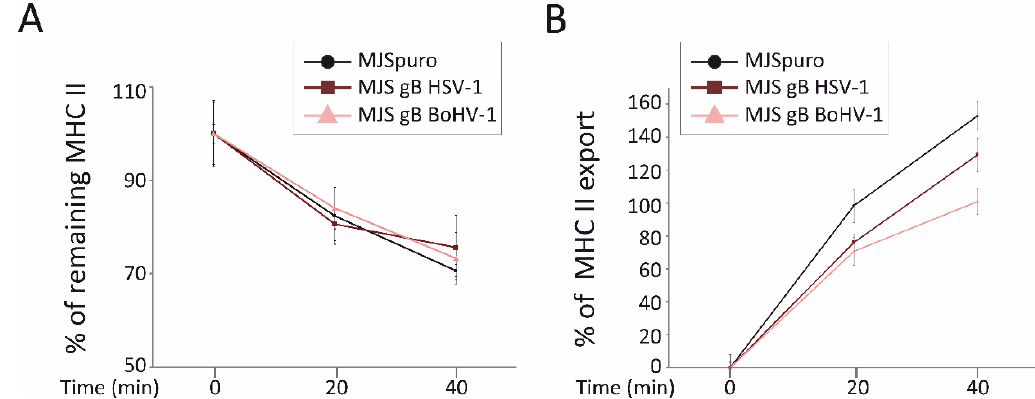
Figure 6. HSV-1 and BoHV-1 gB do not a ff ect internalization but contribute to a retarded appearance of MHC II at the cell surface. ( A ) An internalization assay was performed on MJS HSV-1 gB (dark brown line), MJS BoHV-1 gB (pink line), or control MJSpuro (black line) cells stained on ice with anti-MHC class II L243 antibody and PE-conjugated IgG. The cells were then shifted to 37 ◦ C for 20 or 40 min. The mean fluorescence intensities of remaining MHC II were assessed by flow cytometry for triplicate samples and compared with MHC II at time point 0 (set as 100%). The di ff erences between MHC II levels were statistically insignificant. ( B ) For the MHC II export assay, the cells were stained on ice with a saturating amount of anti-MHC class II L243 antibody and incubated at 37 ◦ C for 20 or 40 min in the presence of allophycocyanin (APC)-conjugated L243 MAb detecting newly arrived MHC II. The mean fluorescence intensities of MHC II staining were normalized to the values for time point 0 samples and depicted as a percentage of the increase in MHC II appearance on MJSpuro (black line) or MJS-gB cells. Results are representative of three independent experiments. The statistical significance of di ff erences between MHC II on MJSpuro and gB-expressing cells at 20 or 40 min was estimated by a t -test; p ≤ 0.01.